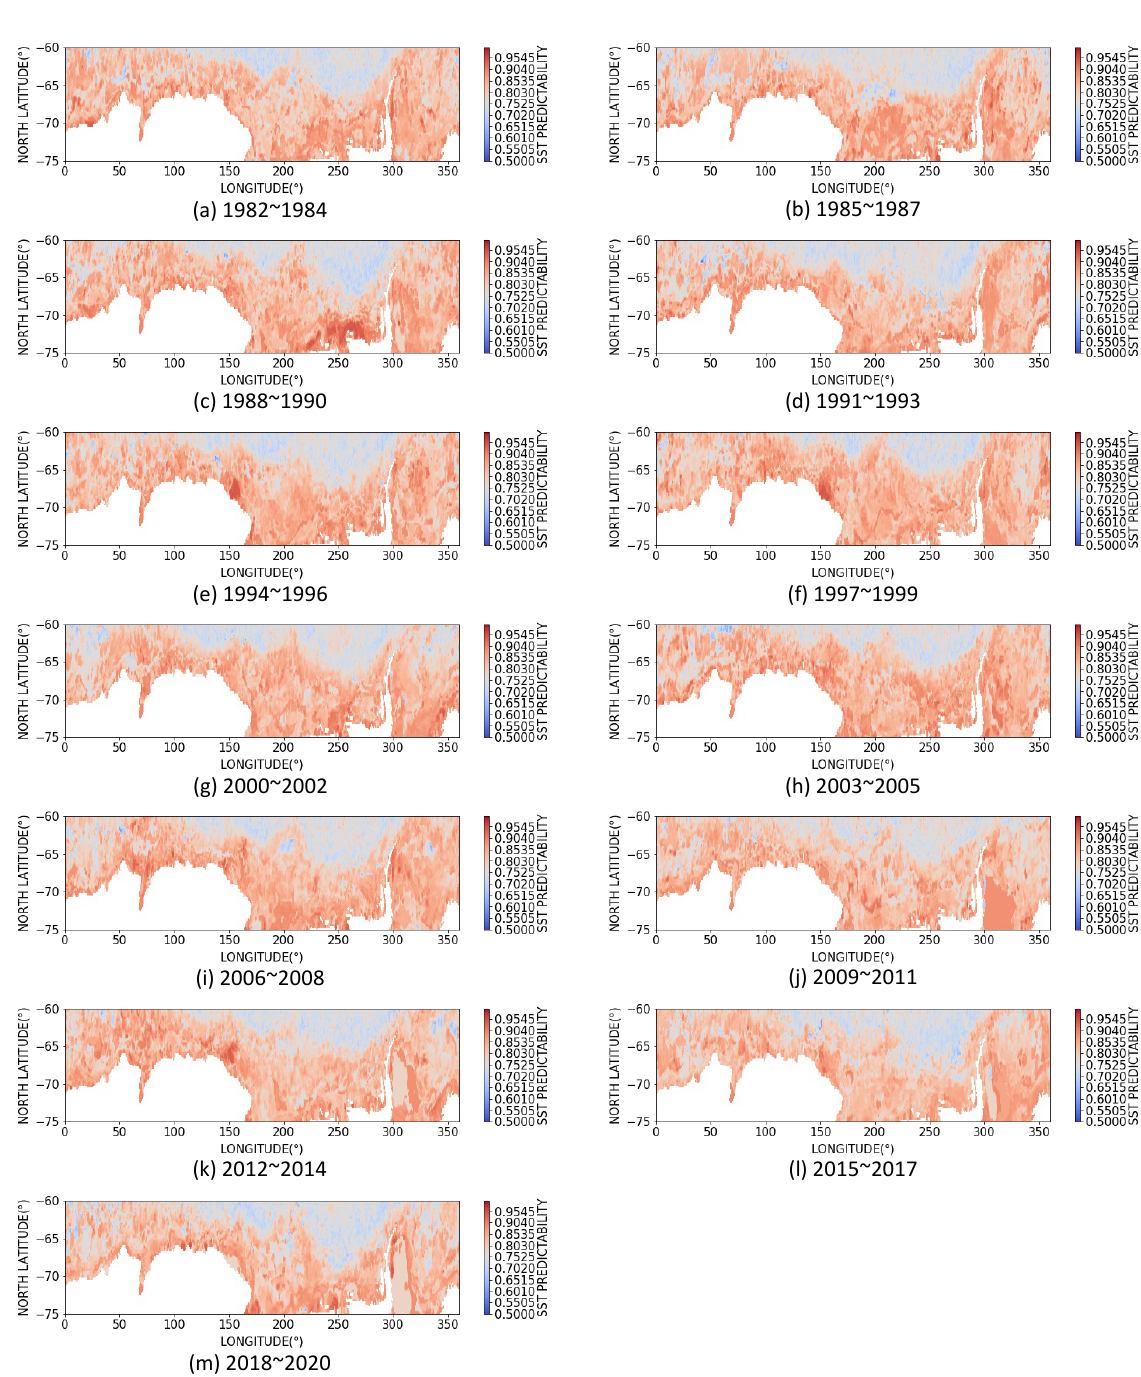
Figure 17. The predictability of SST in the Antarctic Ocean in 13 time periods from 1982 to 2020. To explore the dynamic change trends of SST predictability, we measure the gradient of the predictability sequences in three local sea areas. Figure 18 shows the gradient of the SST predictability sequences in the East China Sea, the Bohai Sea, and the Antarctic Ocean. The predictability of SST in the regions close to the mouth of the Yangtze River, the mouth of the Yellow River, and the southeastern coast of China decrease rapidly, which means the SST records of these regions become more and more chaotic. This may be due to China’s rapid economic development in recent decades and the increased shipping and industrial use of the mouths of the two major rivers and the ports along the coast. The SST predictability in the Antarctic Ocean shows more drastic changes than in the